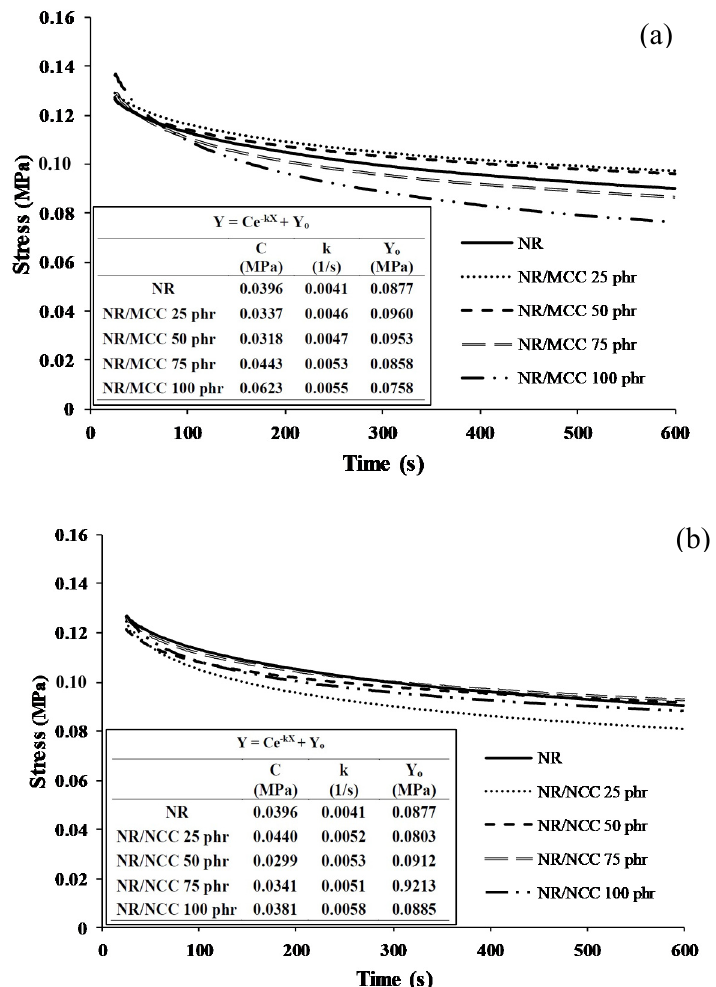
Figure 8. Stress relaxation curves of samples: ( a ) pure NR and NR with MCC at 0, 25, 50, 75, and 100 phr, ( b ) pure NR and NR with NCC at 0, 25, 50, 75, and 100 phr.